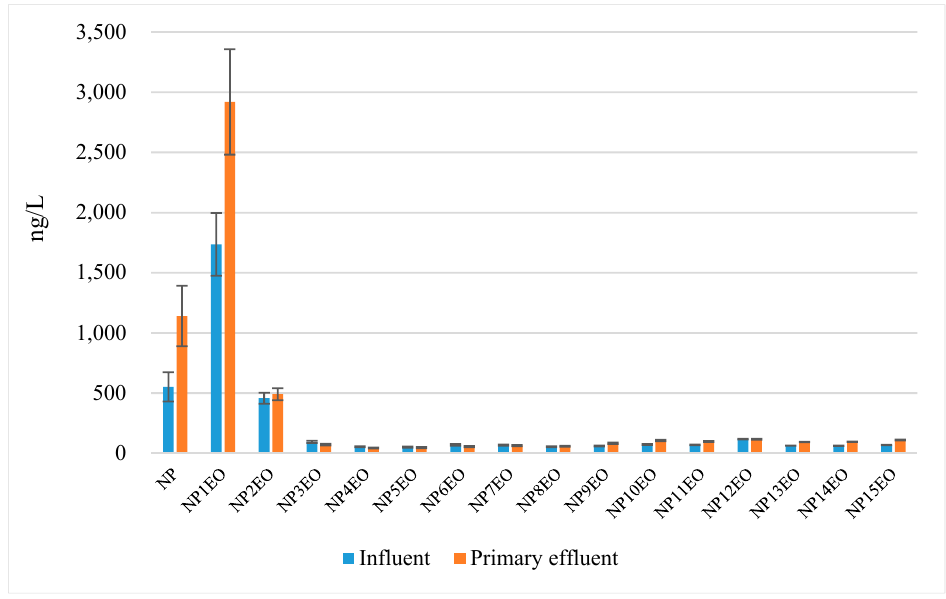
Figure 6. Concentration of NP and individual NP n EO for F2.